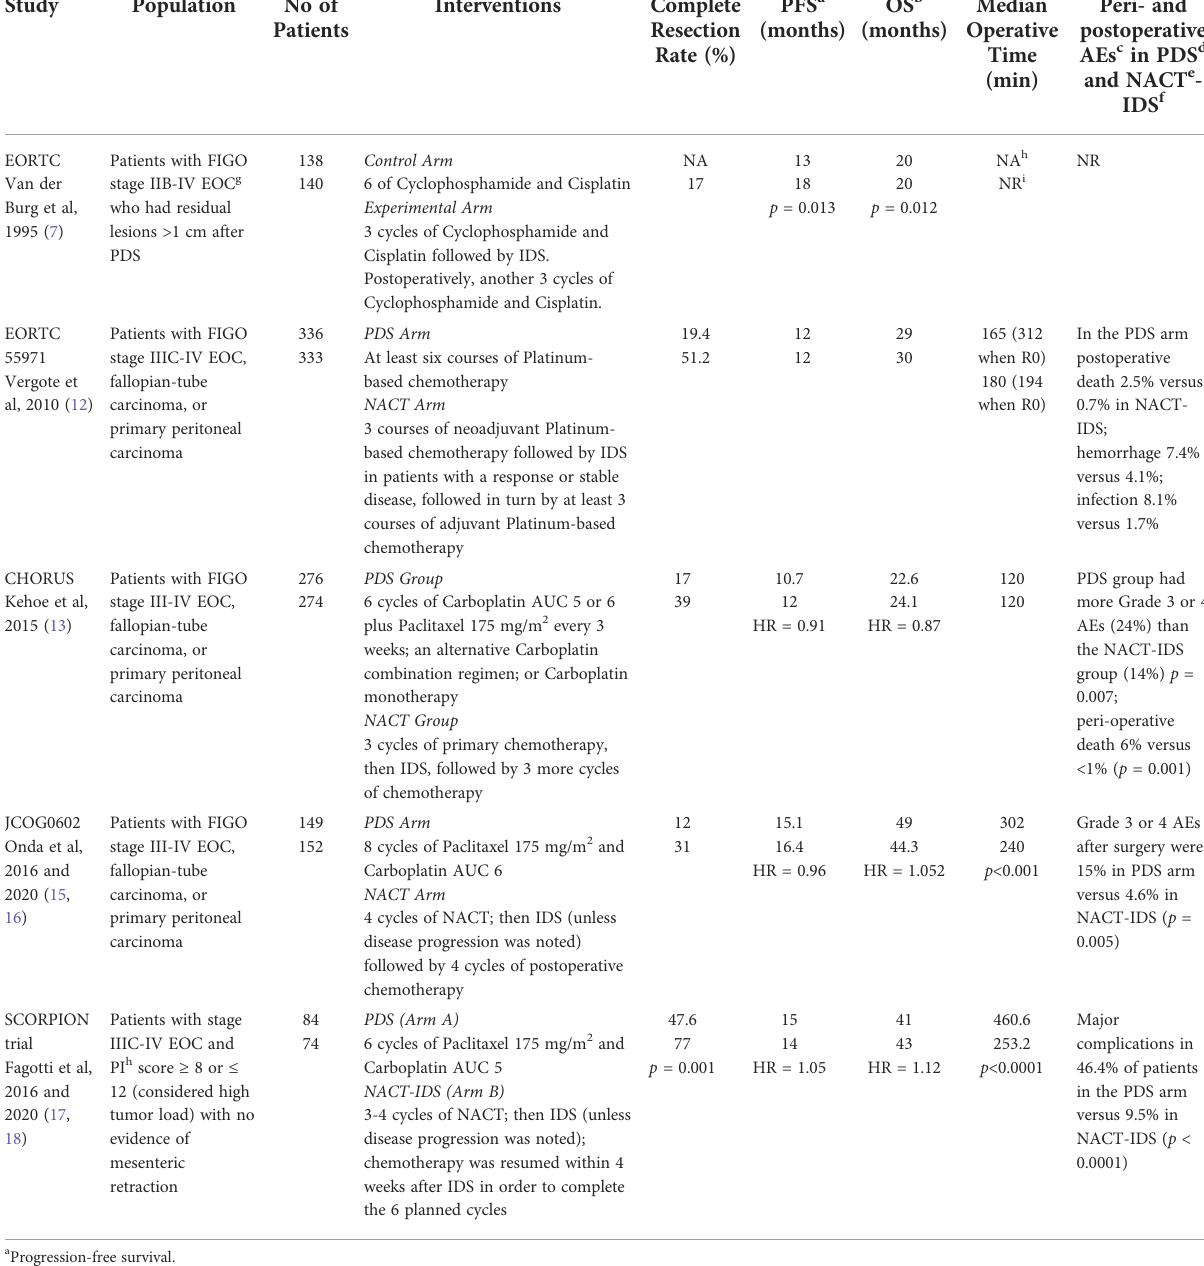
TABLE 1 Randomized phase III trials that compared neoadjuvant chemotherapy and interval debulking surgery with primary debulking surgery in patients of advanced epithelial ovarian cancer.